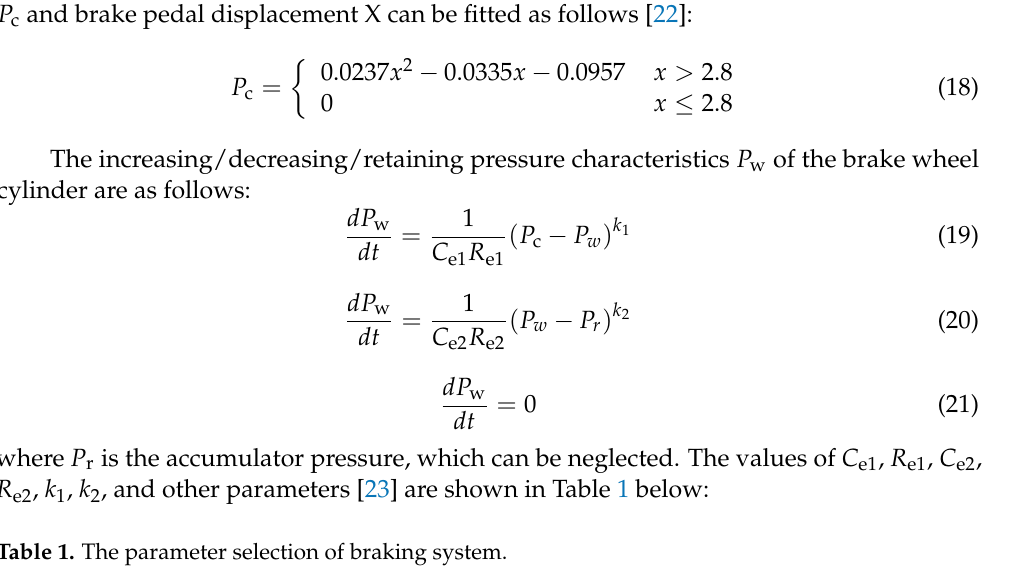
Table 1. The parameter selection of braking system. Parameter The